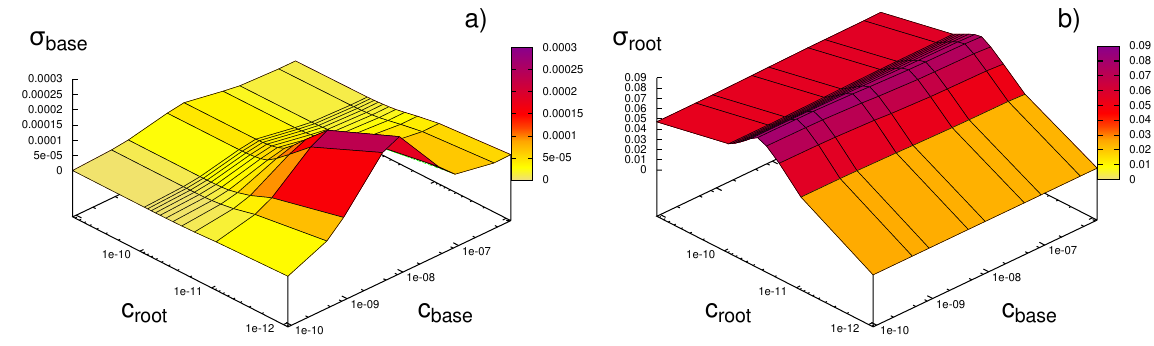
Fig. 4. Entropy production of (a) baseflow and (b) root water uptake as a function of the two model parameters c base and c root . The combined MEP-state of baseflow and root water uptake lies at the intersection of the two “ridges” in (a) and (b) , the corresponding values can be found in Table A.